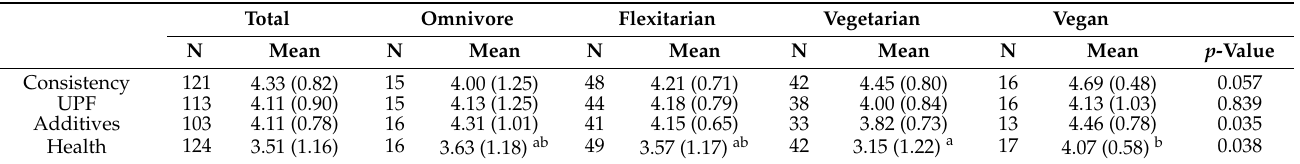
Table 11. Mean scores and standard deviation of the objective knowledge about sustainability characteristics of PBCAs 1 by participants’ diets.